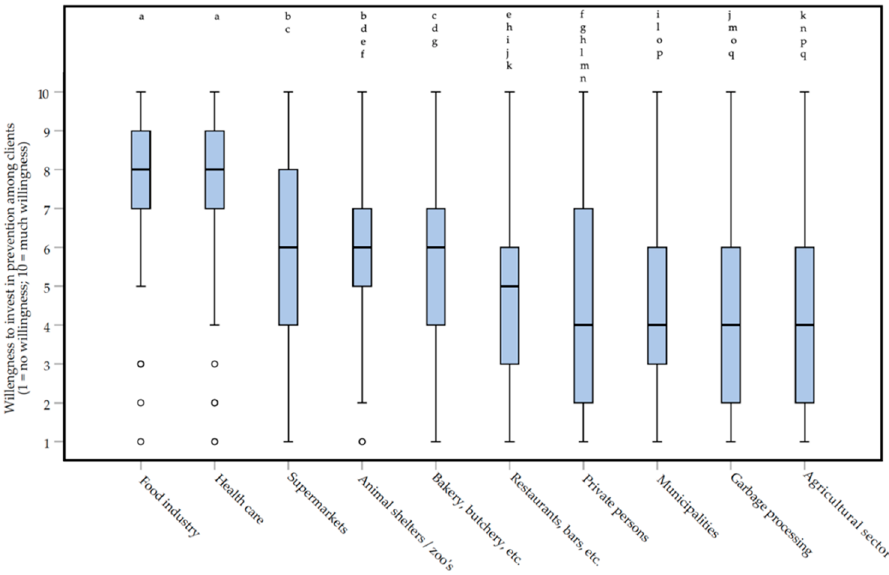
Figure 7. Box plots presenting the willingness to invest in prevention among clients in di ff erent sectors on a 1 (no willingness) to 10 (much willingness) rating scale. Willingness was indicated by 129 Dutch pest controllers, participating in an online survey about the treatment of rats ( Rattus rattus and Rattus norvegicus ) and mice ( Mus musculus ). Di ff erences between the two clients that are not statistically significant are indicated with letters above the bars.